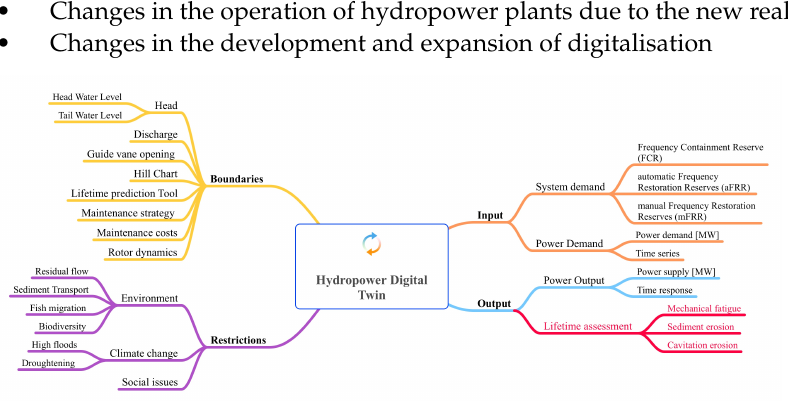
Figure 3. New installed Hydropower Digital Twin to interconnect energy source (machine unit) and energy vector (electrical